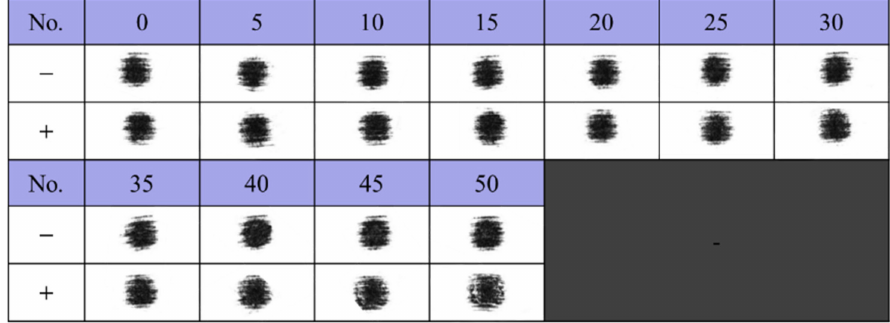
Figure 13. Carbon imprints of the abraded electrode at the electrode force of 400 kgf during continuous